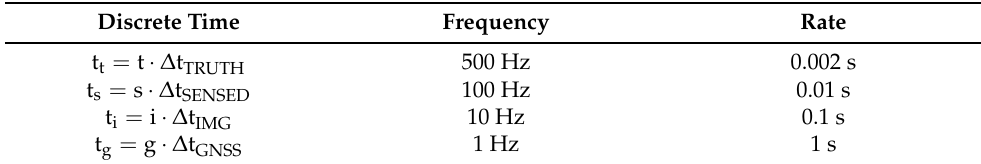
Table 13. Example of frequencies of the different sensors.